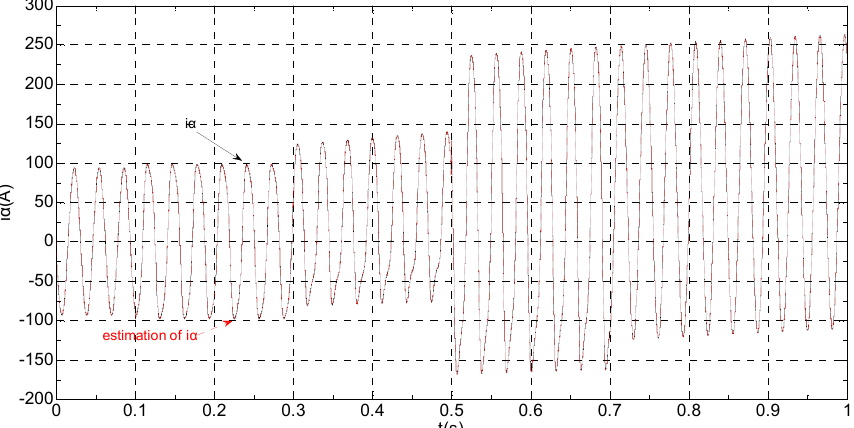
Figure 10. The actual and estimated value of i α .